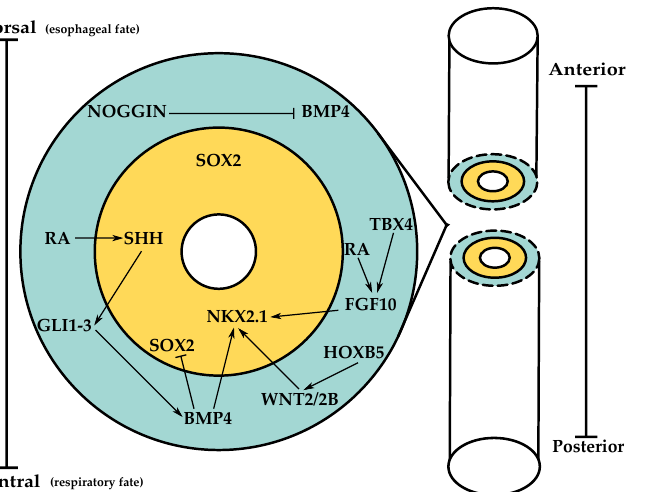
Figure 1. Summary of the molecular players involved in lung specification. A BMP gradient elicits dorsal SOX2 expression (esophageal progenitors) vs. ventral NKX2.1 expression (respiratory progenitors). Yellow, endoderm; blue,